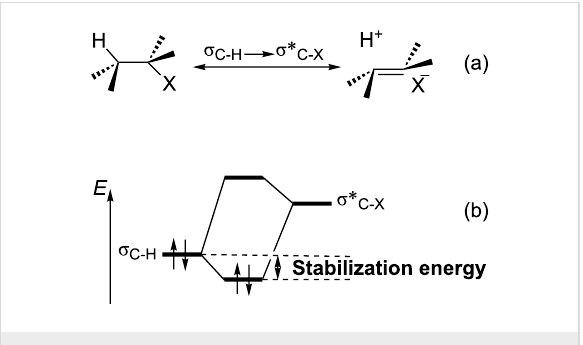
Figure 1: (a) Schematic representation of the vicinal σ C − H →σ * C − X interaction by double-bond/no-bond resonance. (b) Stabilization energy because of the hyperconjugative interaction between σ C − H and σ * C − X orbitals.